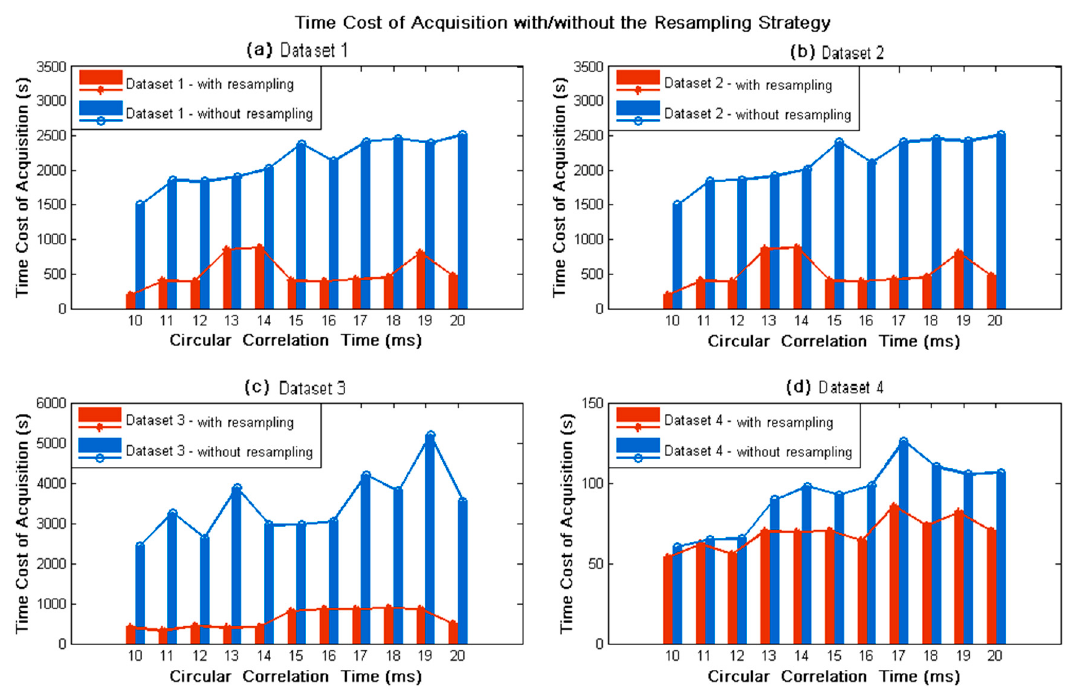
Figure 13. Time cost of signal acquisition with/without the resampling strategy for variable circular correlation time. Red bars and plot represent acquisition results with the resampling strategy, while blue ones are for that of the conventional acquisition algorithm.